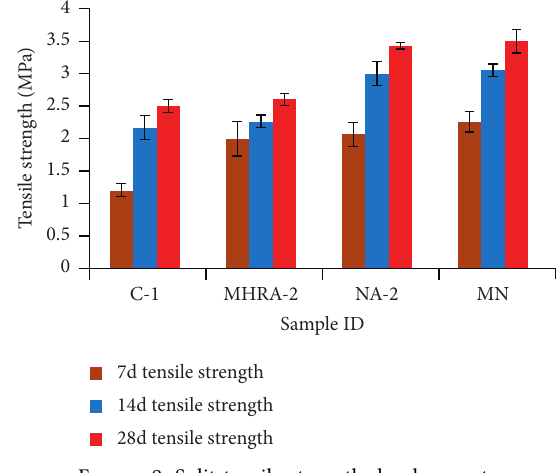
Figure 9: Split-tensile strength development.